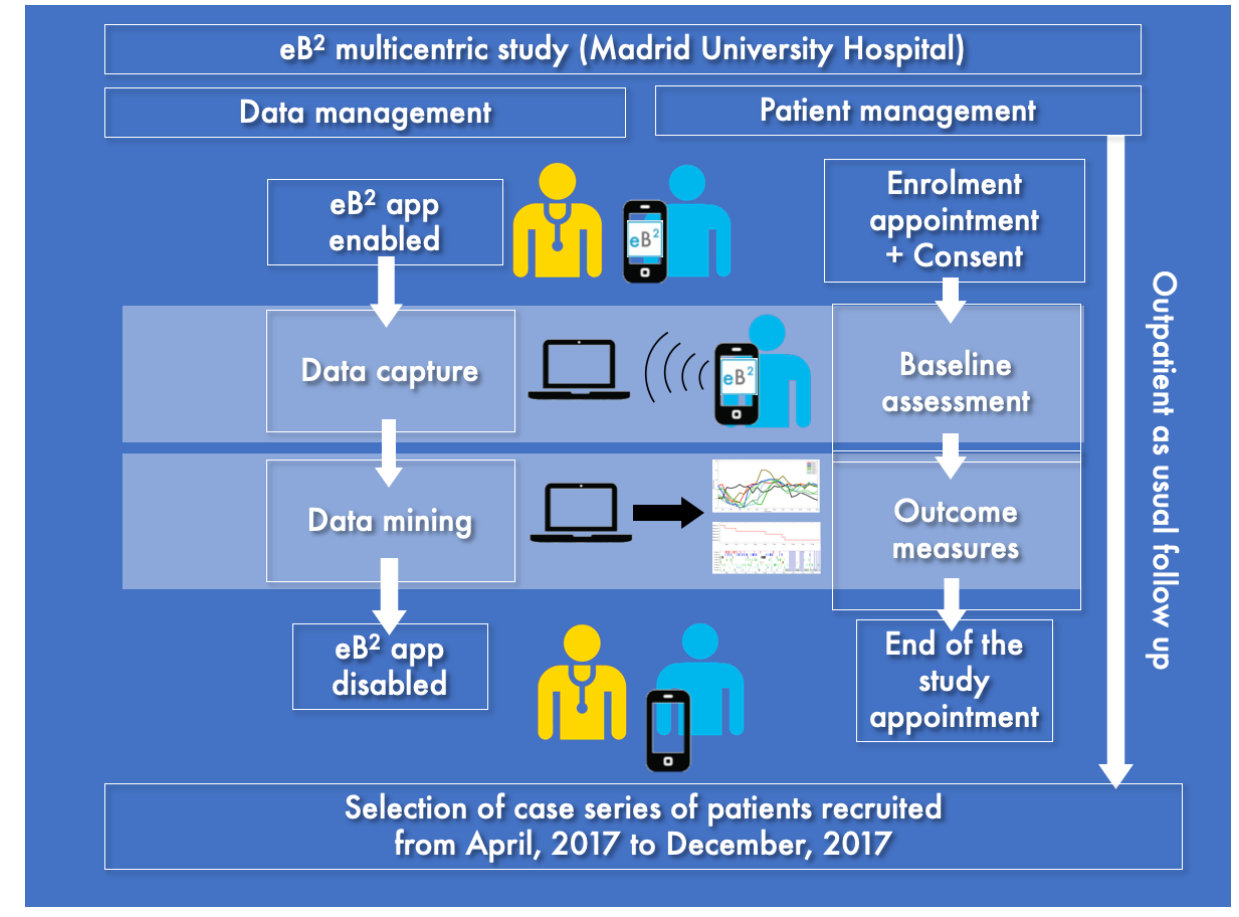
Figure 1. Visual representation of the study protocol. eB 2 : Evidence-Based